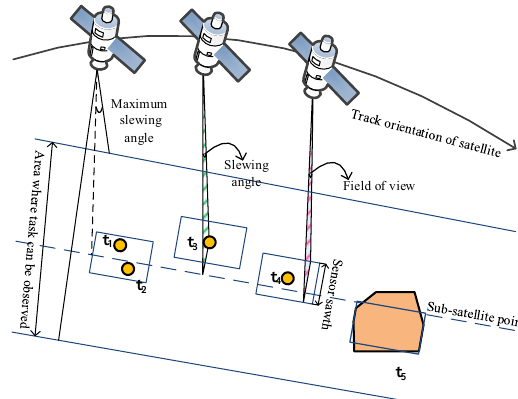
Figure 1. Illustration of satellite observing activity